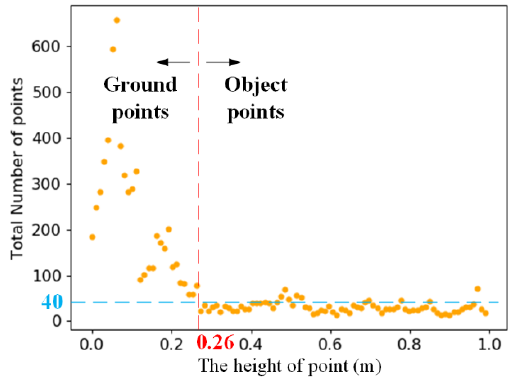
Figure 9. The height distribution of the point cloud.